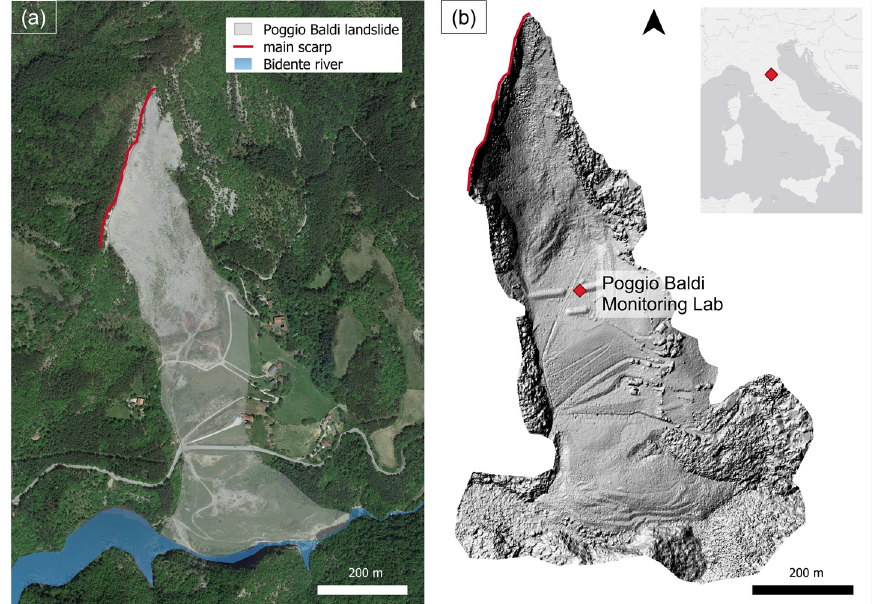
Figure 1. Poggio Baldi landslide overview. The main subvertical landslide scar is highlighted in red ( a ). The location of the Poggio Baldi Monitoring Lab is also reported in the DEM ( b ).